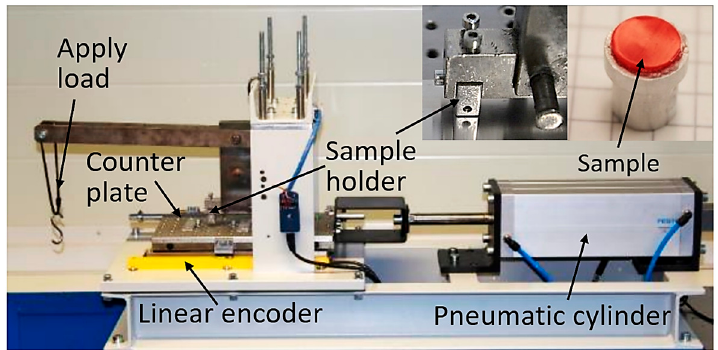
Figure 5. Experimental setup to characterize the tribological behavior of soft polymers: Sample holder and polymer sample (upper right); Experimental test stand at AC2T research GmbH for reciprocal tribological experiments.